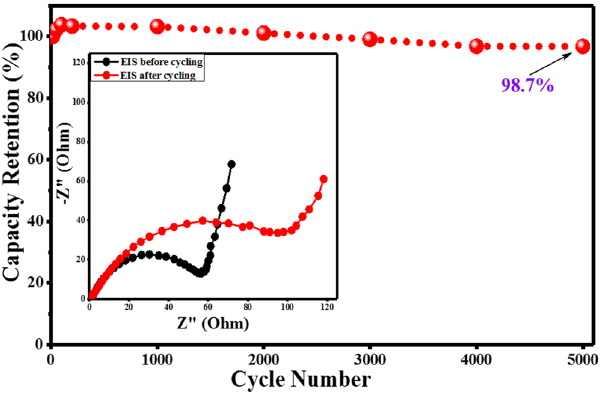
Figure 8. Cyclic stability of G-NiO//AC supercapattery; inset shows the comparative EIS spectra of the device showing the internal resistances before and after